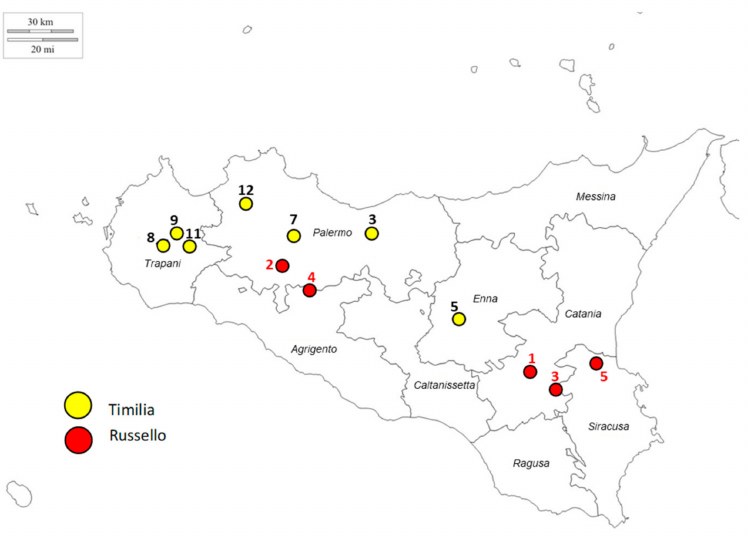
Figure 1. Map of Sicily showing the sampling locations and district